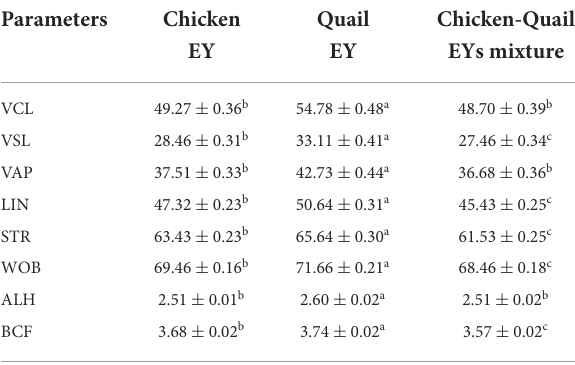
TABLE 5 Effects of adding and combining egg yolks (EY) of chicken and/or quail to the Tris glycerol extender on motion kinetics parameters of ram sperm post-thawing.